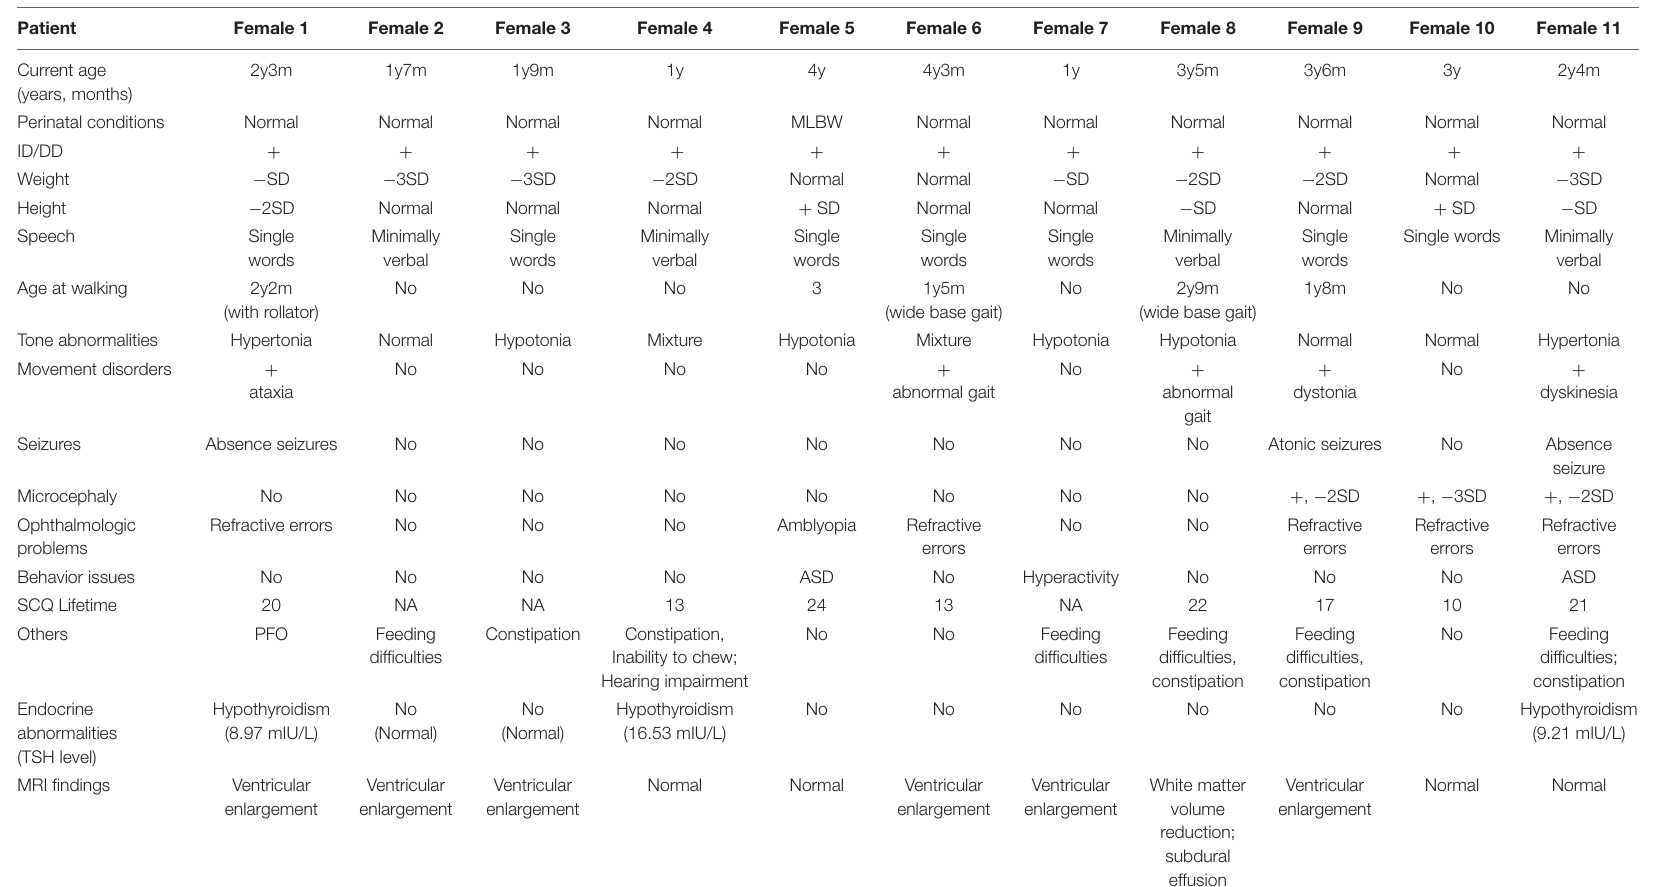
TABLE 2 | Summary of demographic information and phenotypic features in 23 patients with DDX3X variants.